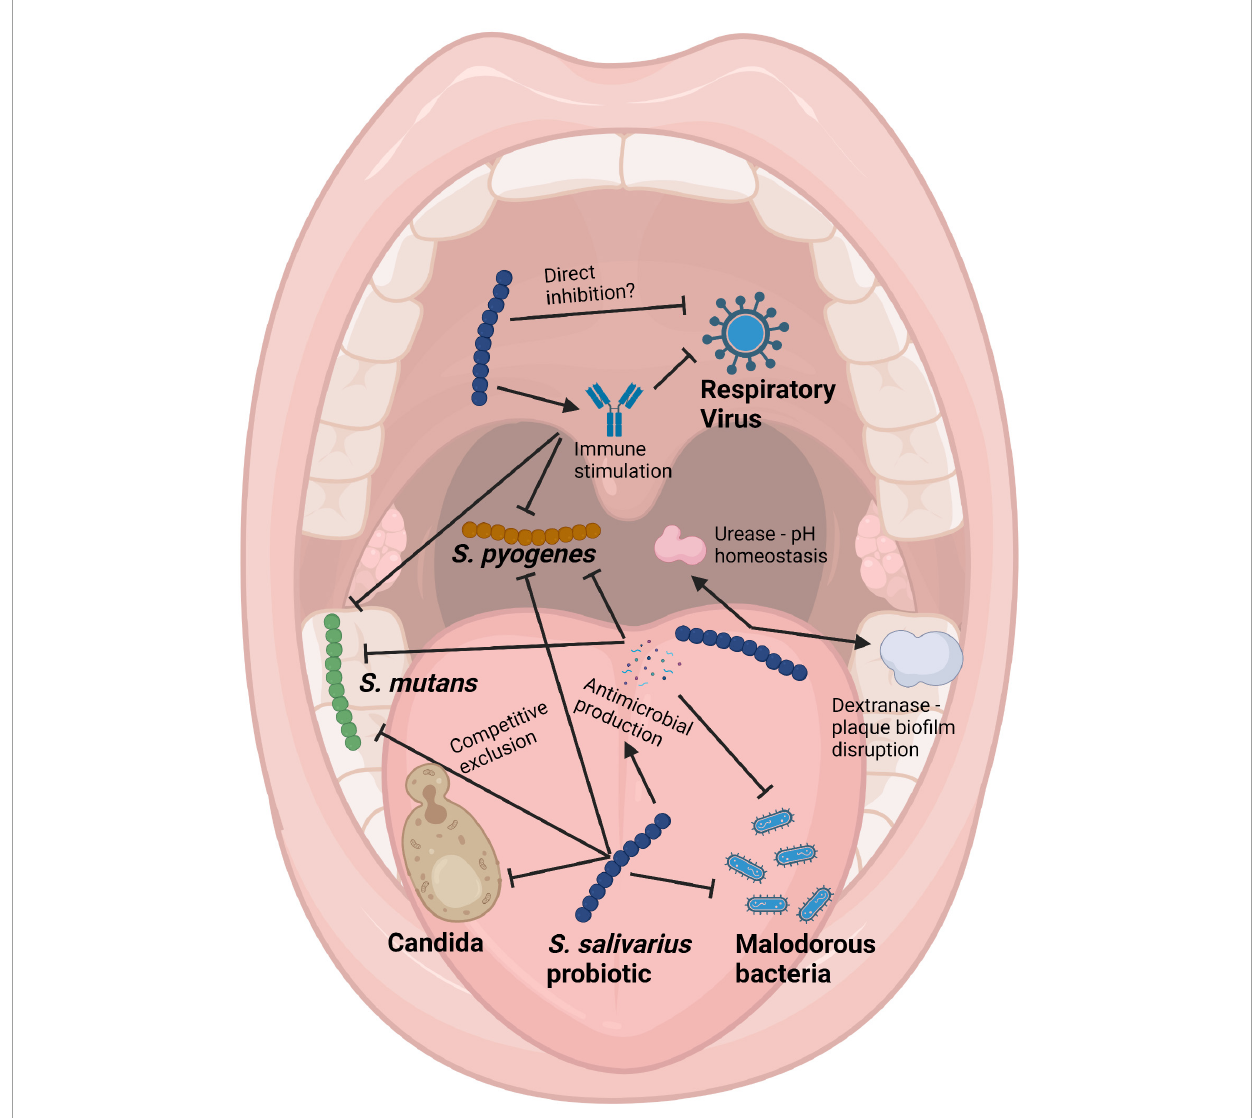
FIGURE4 Schematic of the mouth showing some of the health benefits to the host provided by Streptococcus salivarius probiotics. Pointed arrows represent production of molecules, while blunt arrows signify inhibition. Created with